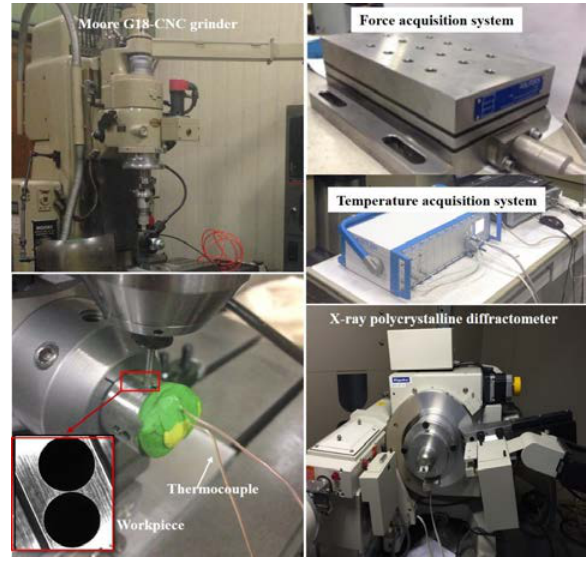
Fig. 2. Experimental and measuring